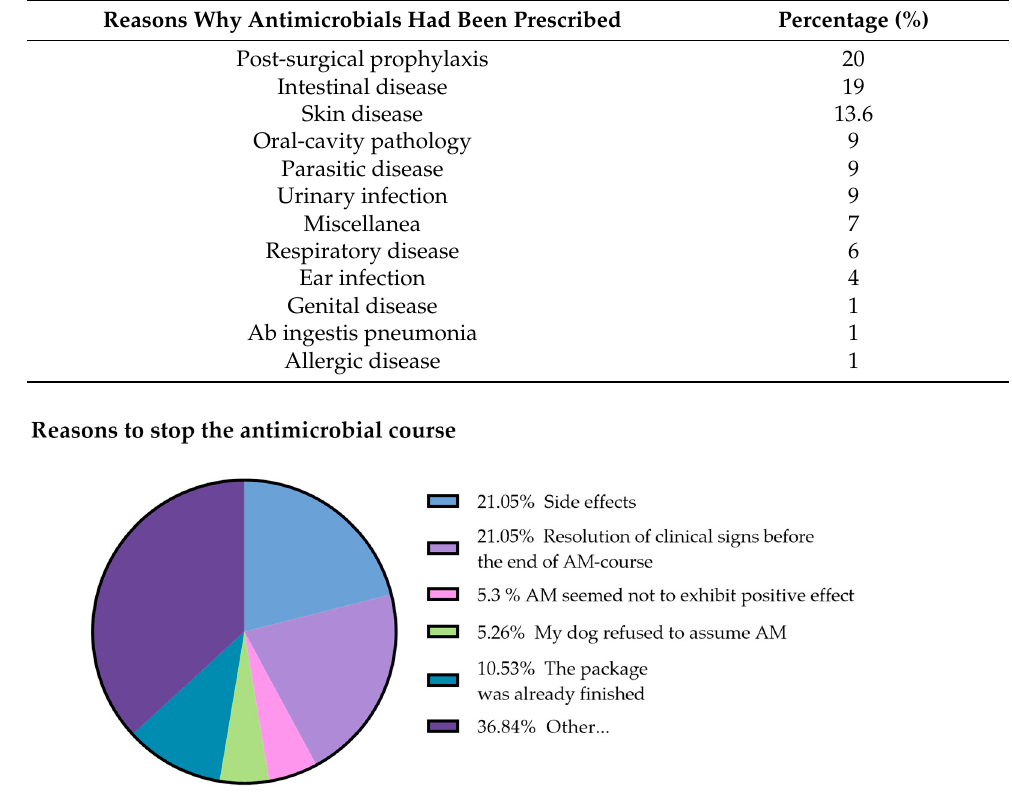
Table 2. Reasons why oral antimicrobials have been prescribed by the veterinarians. Data are expressed as percentage of the total number of dogs who had received antimicrobials in the previous 12 months, as declared by respondents.